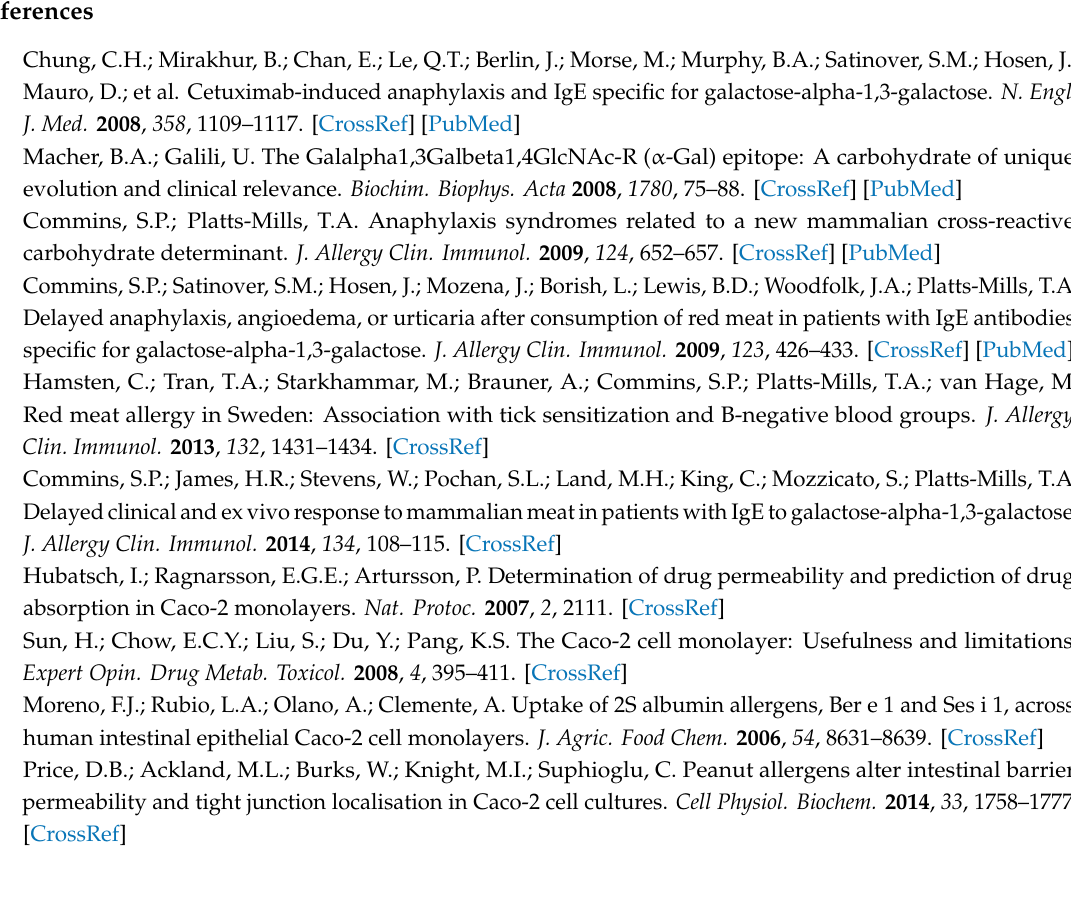
s1. Figure S1: Immunoblot analysis of in vitro gastric digestion products from BSA-NAl using polyclonal anti-BSA antibody; Figure S2: Uptake of BSA- α -Gal and BSA in Caco-2 cells after 4 h of incubation at 37 ◦ C analyzed by confocal laser scanning microscopy; Figure S3: Fluorescent detection of BSA and BSA- α -Gal; Figure S4: Western blot detection of galectin-3 using polyclonal anti-human galectin-3 antibody in Caco-2 cell lysates; Figure S5: SDS PAGE analysis of pepsin control solution with pepsin only at 0 and 4 h time point, stained by CBB-R; Table S1: Preparation of stock solution of simulated gastric fluid